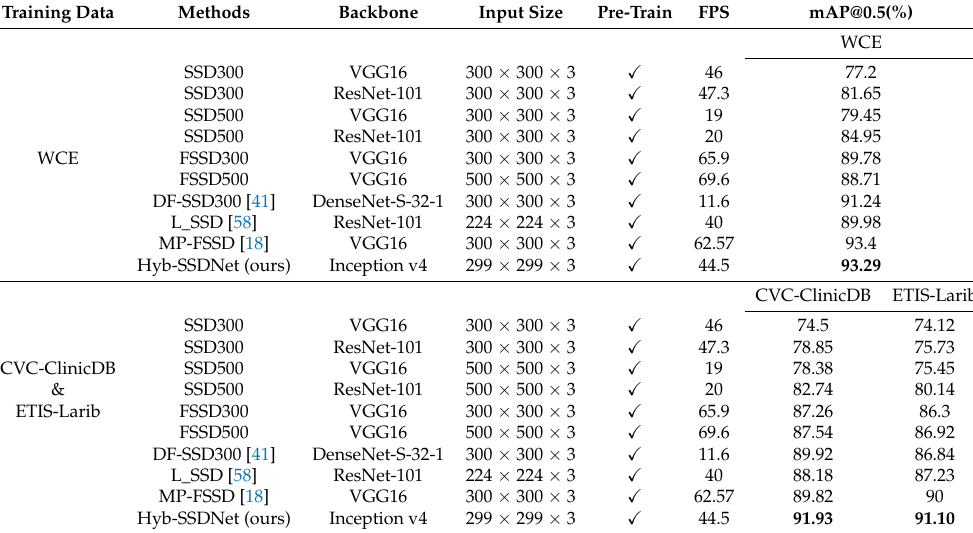
Table 2. Comparison with previously published methods based on SSD, WCE, CVC-ClinicDB, and ETIS-Larib test sets. Pre-train means that a pre-trained backbone was adopted to initialize the model or it was initialized from scratch. The speed (FPS) and the (mAP) performances were tested using google Colab pro+